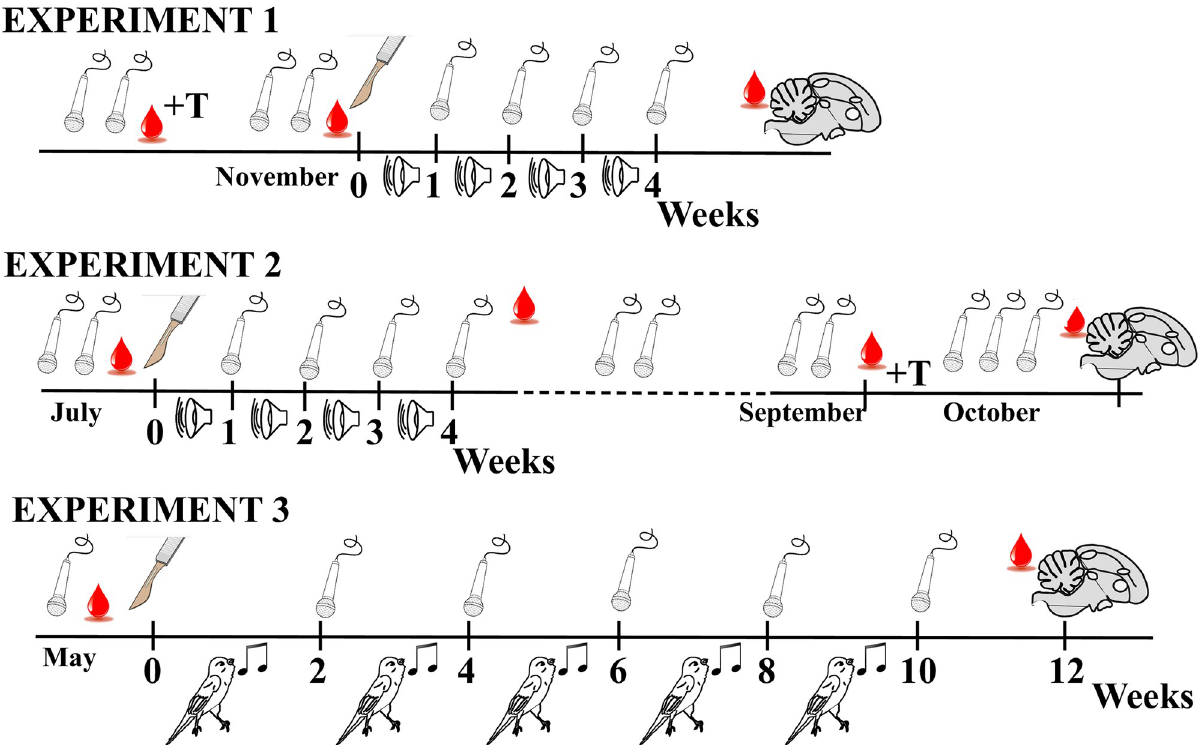
Fig 1. Schematic representation and comparison of the experimental designs implemented during experiments 1 to 3. The different symbols present in the figure represent recording sessions (microphone), tutoring with song playback (loudspeaker), tutoring with live male tutors (bird singing), surgeries and application of ChABC or saline over HVC (scalpel), subcutaneous implantation of a Silastic ™ capsule filled with testosterone (+T), collection of blood sample (red drop of blood) and collection of the brain at the end of the experiment (sagittal section through brain).